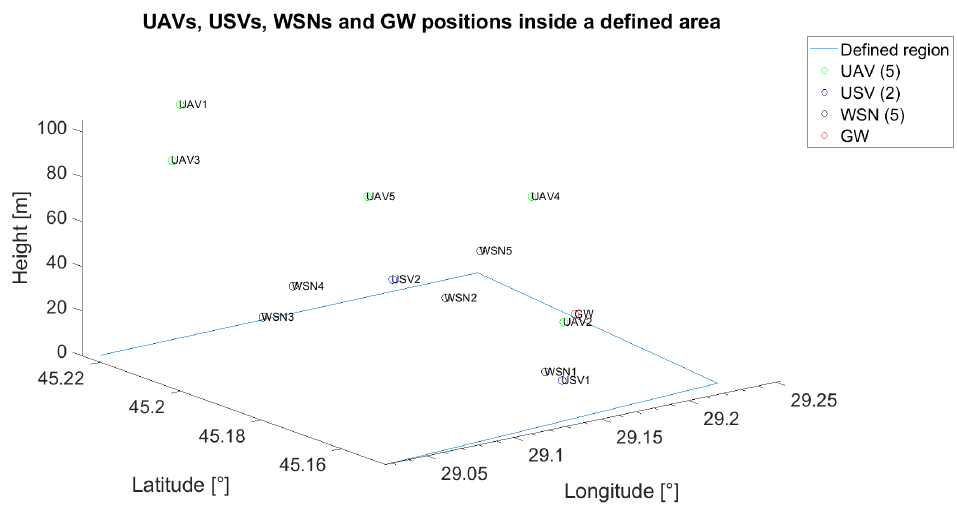
Figure 2. FSANET-WSN network example: n UV = 7, n UAV = 5, n USV = 2, M =